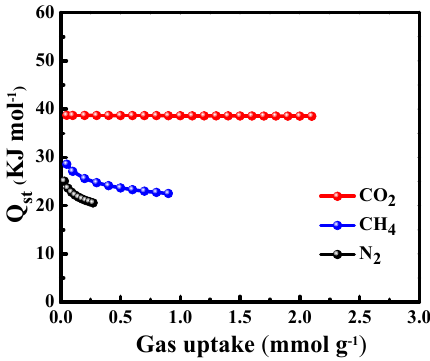
Figure 9. Isosteric heats of adsorption for CO 2 , CH 4 , and N 2 on the ACSs-N.